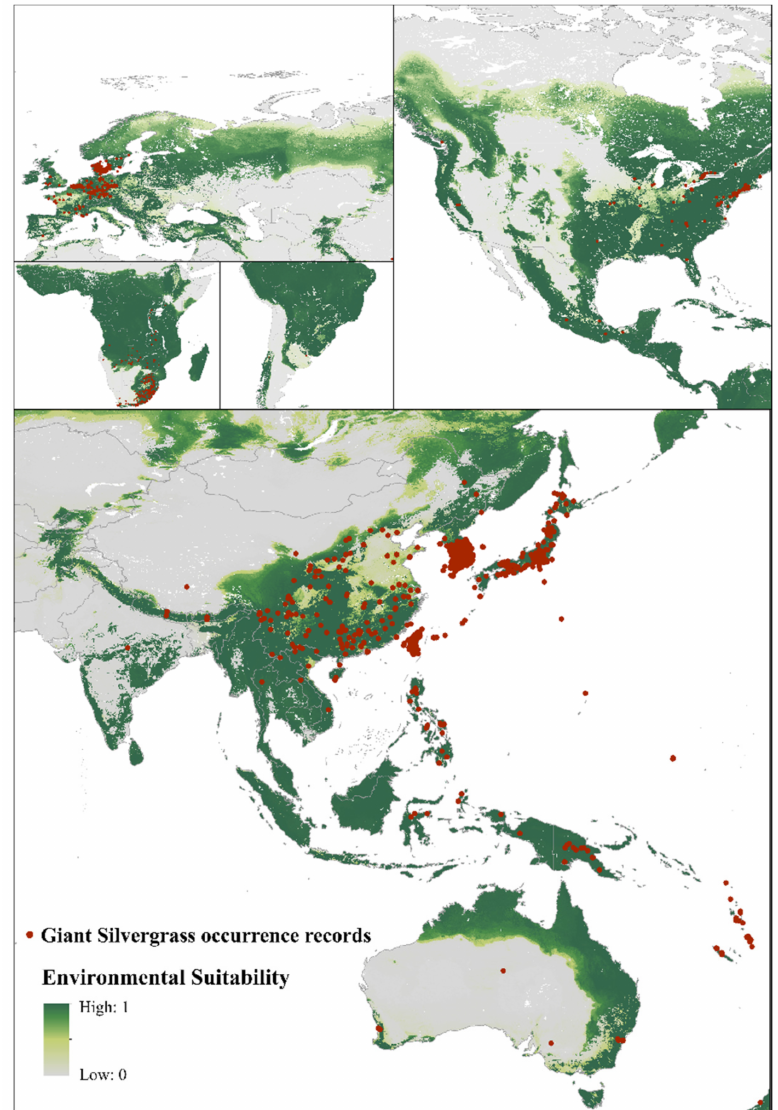
Figure 2. Spatial distribution of the global occurrence records for giant silvergrass.